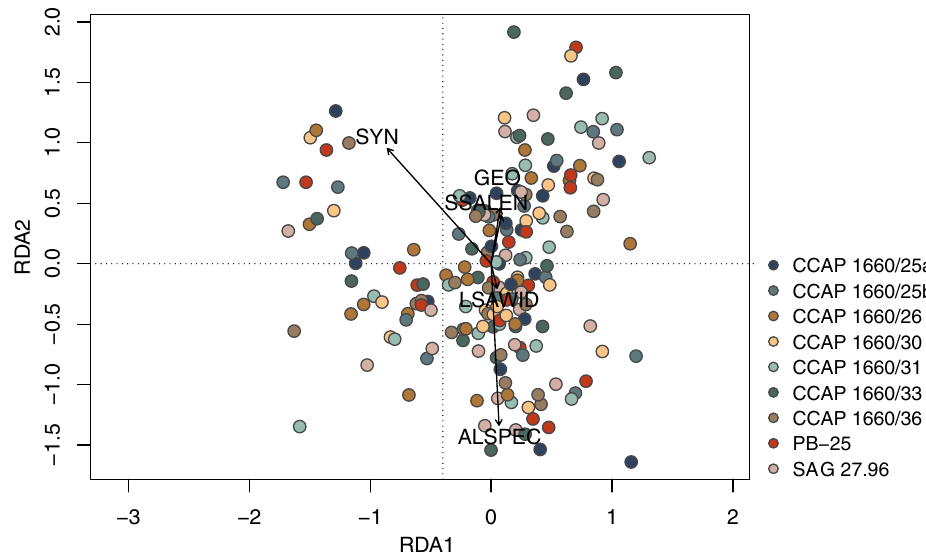
Figure 9. Ordination diagram for redundancy analysis (RDA) of morphometric data and shown syngen (SYN), geographic region (GEO), and algal features (ALSPEC, LSAWID and SSALEN) as explanatory